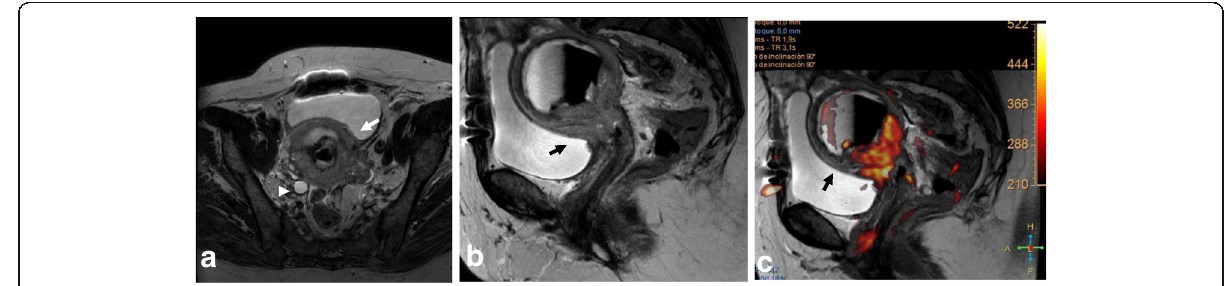
Fig. 18 Cervical cancer. a Axial oblique T2WI shows a cervical mass (arrow), with hematometra and ureteral invasion (arrowhead) (IIIB). b Sagittal T2WI shows loss of the hypointense rim of the posterior bladder wall suggesting invasion (arrows). c T2WI+DWI reveals no invasion of the bladder wall